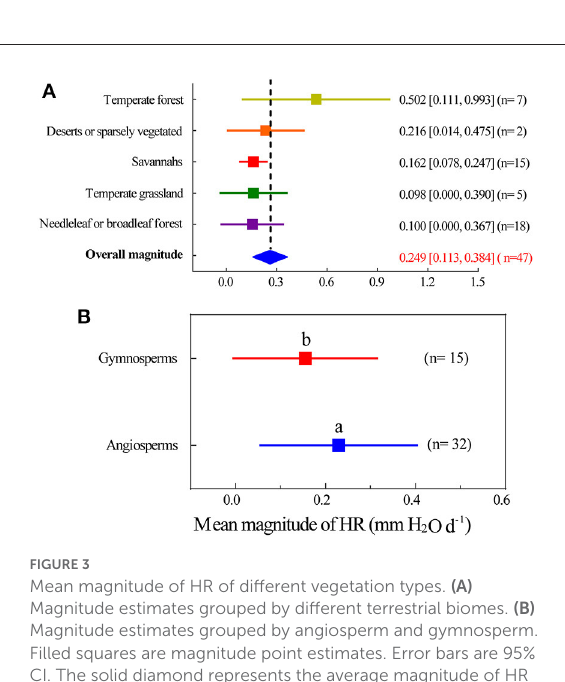
FIGURE3 Mean magnitude of HR of different vegetation types. (A) Magnitude estimates grouped by different terrestrial biomes. (B) Magnitude estimates grouped by angiosperm and gymnosperm. Filled squares are magnitude point estimates. Error bars are 95% CI. The solid diamond represents the average magnitude of HR and its 95% CI is represented by the width of the diamond. Different lowercase letters indicate significant difference at the 0.05